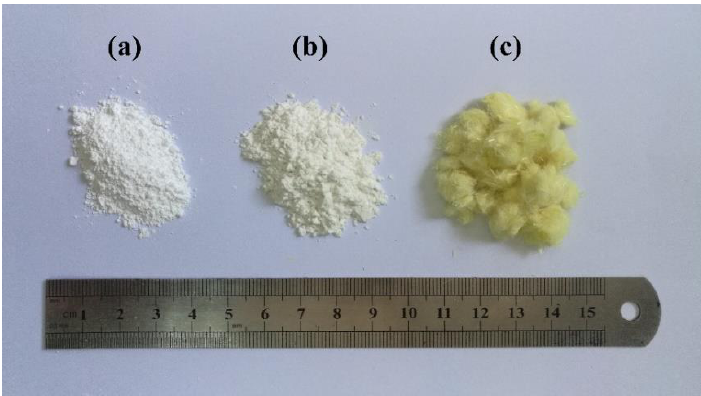
Figure 1. Appearance of different reinforcements. ( a ) Nano-CaCO 3 particles, ( b ) CaCO 3 whiskers, ( c ) 2 mm-aramid fibers.